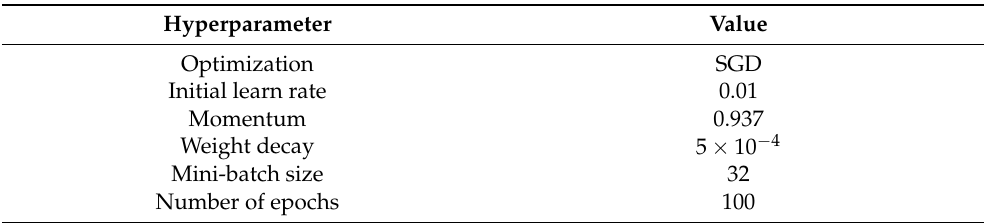
Table 2. The hyperparameter settings for the network training.